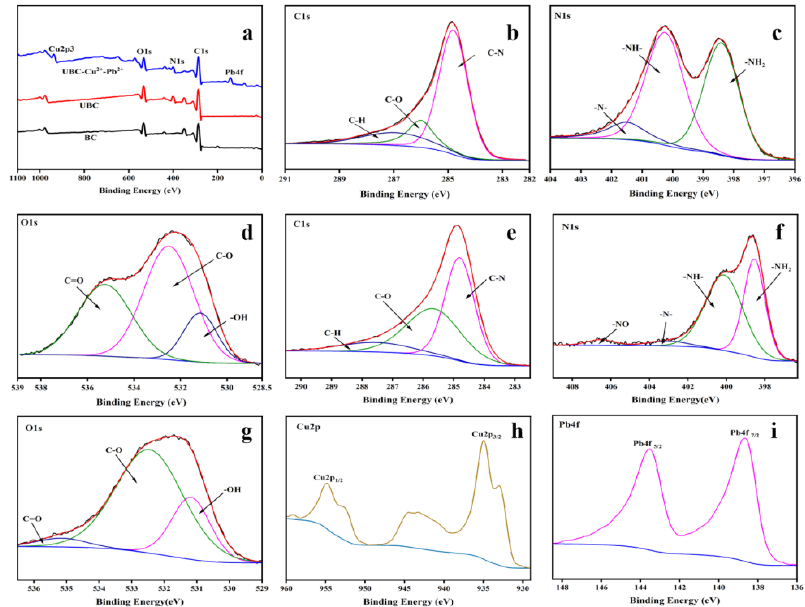
Figure 5. The XPS spectra of BC and UBC ( a ); the high-resolution XPS spectra of C1s, N1s and O1s of UBC ( b – d ); the XPS spectra of C1s, N1s, O1s, Cu2p, and Pb4f of UBC adsorbed for Cu 2+ and Pb 2+ ( e – i